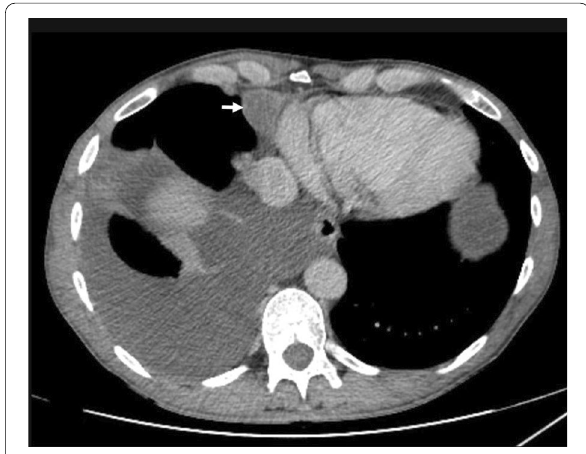
Fig. 21 CT image of a patient with malignant peritoneal mesothelioma and concurrent pleural disease shows pleural based nodules (arrow) and pleural effusion